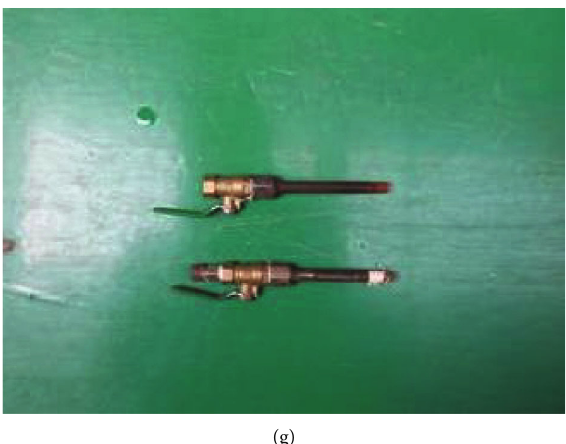
Figure 3: Equipment accessories of true triaxial penetration grouting test device. (a) Upper pressing plate; (b) σ left and right pressing plates; (d) front and rear pressing plates; (e) frame; (f) upper cover plate; (g) slurry inlet pipe and slurry outlet pipe.